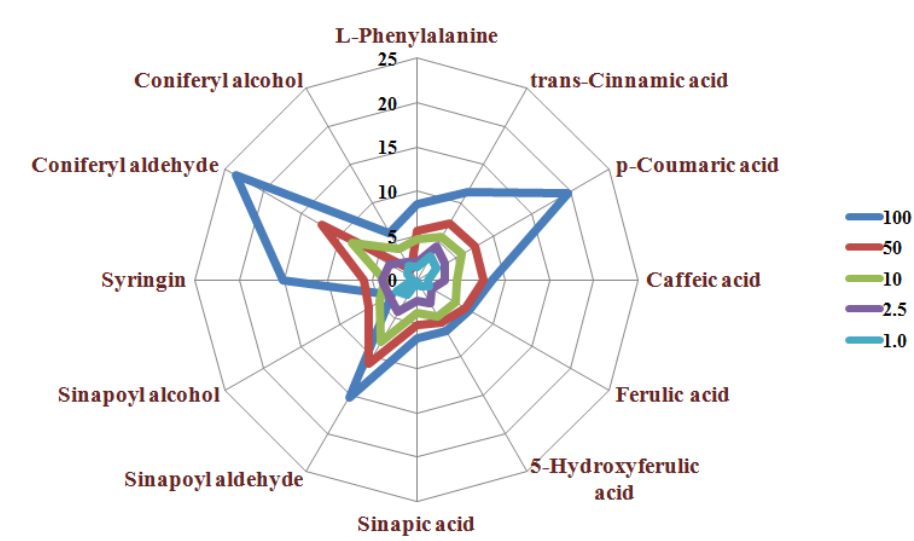
Figure 3. Repeatability of quantitative results of target compounds detected at different dilution ratios.